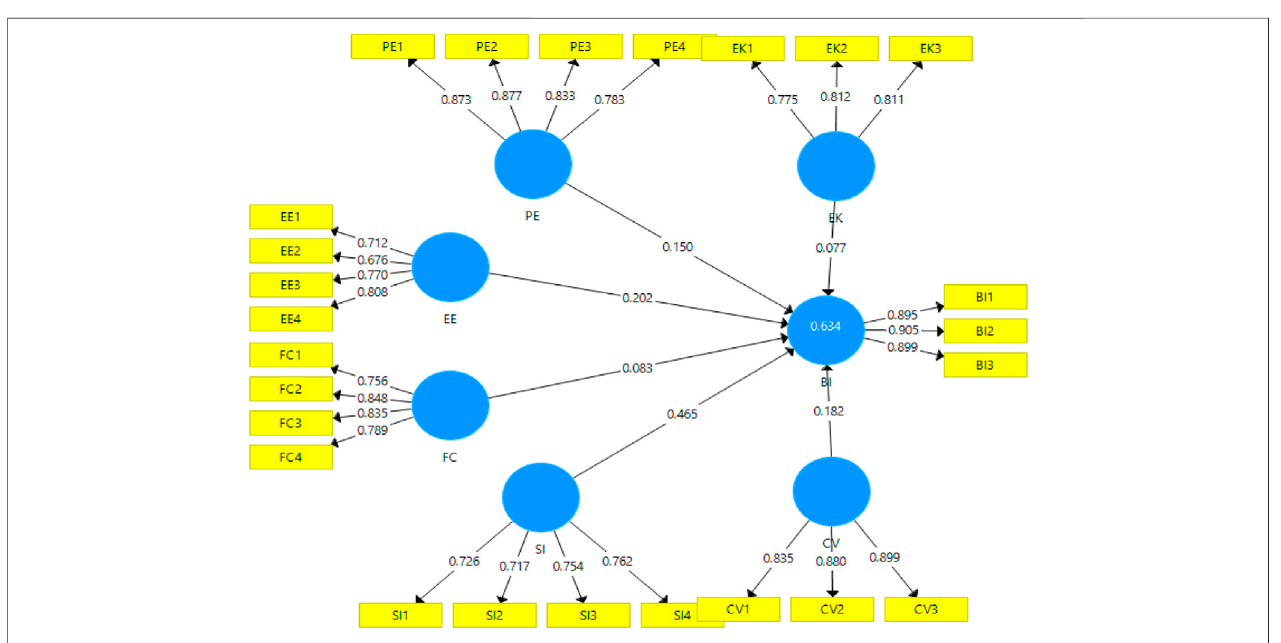
FIGURE 2 | Measurement